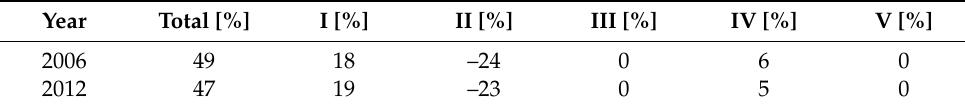
Table 10. The values of DI in the CU H á